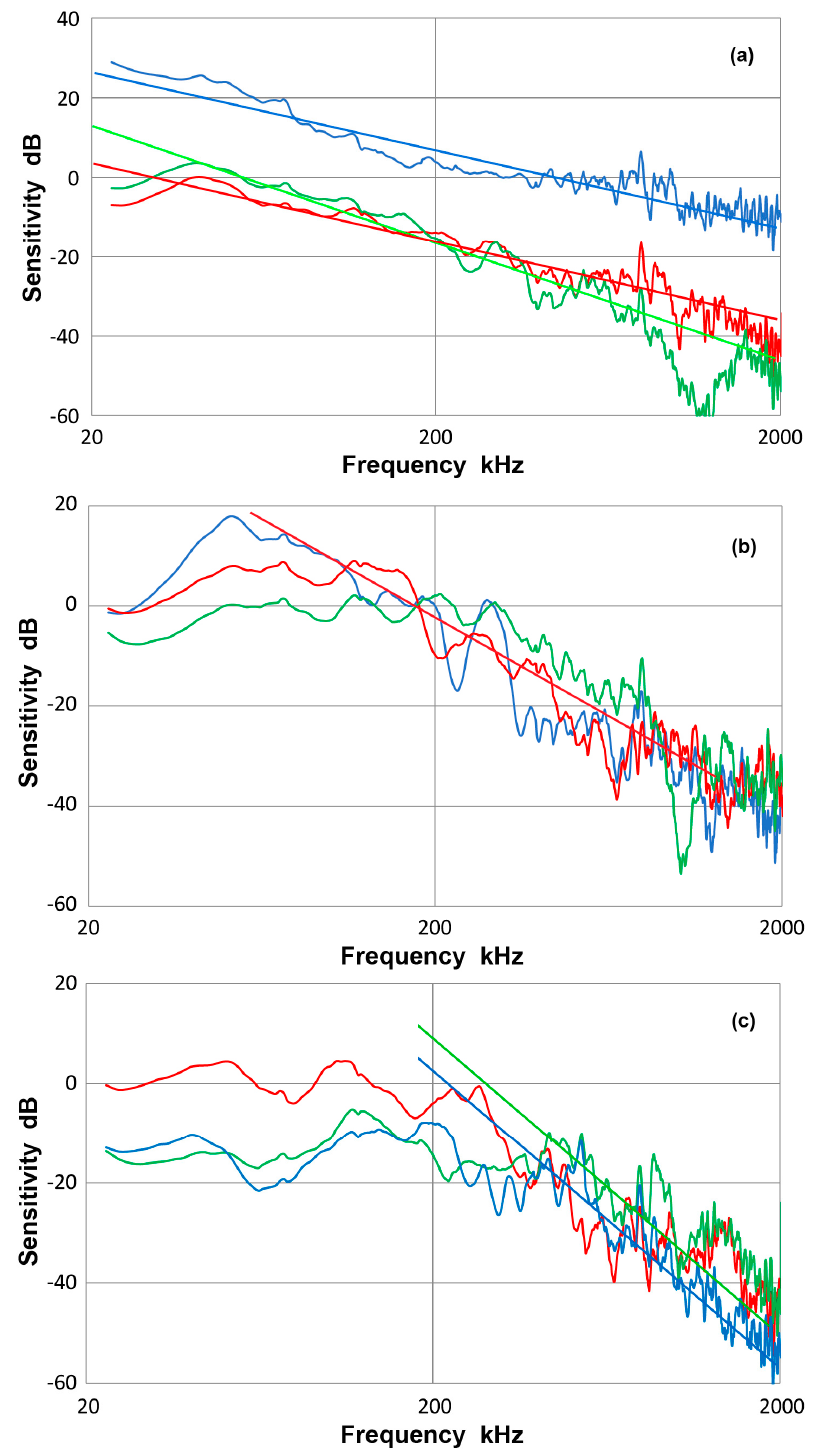
Figure 19. ( a ) Frequency dependence of guided wave sensitivity. Blue -KRN sensor with FET buffer (#11053), red-V103 transducer, green -V101 transducer. Blue and red lines: slope = 1, Green line: slope = 1.5. ( b ) Frequency dependence of guided wave sensitivity. Blue-R6a sensor, red -R15 sensor, green -F30a sensor. Red line: slope = 2. ( c ) Frequency dependence of guided wave sensitivity. Blue -HD50 sensor, red - µ 30D sensor, green -Pico sensor. Blue and green lines: slope = 3.